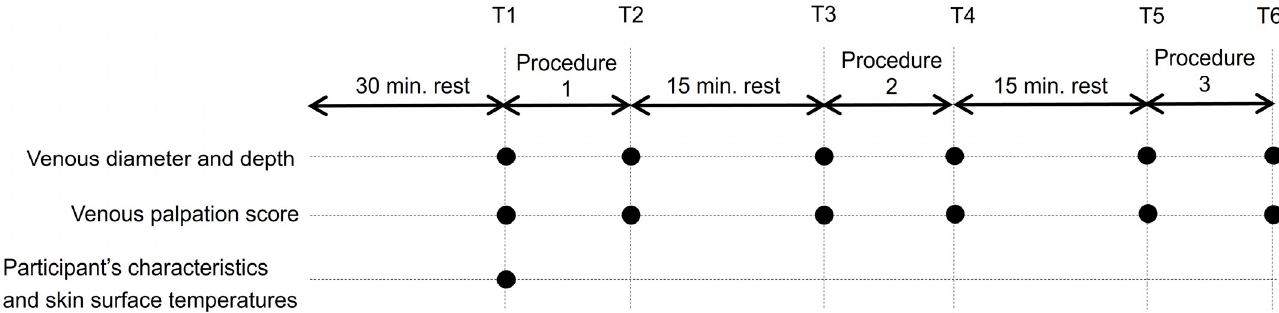
Figure 2. Study protocol. Notes: ( ● ) Measurement points. T1, at the start of the intervention; T2, after the first venous dilation procedure; T3 and T5, after 15 min of rest; T4, after the second venous dilation procedure; T6, after the final venous dilation procedure.